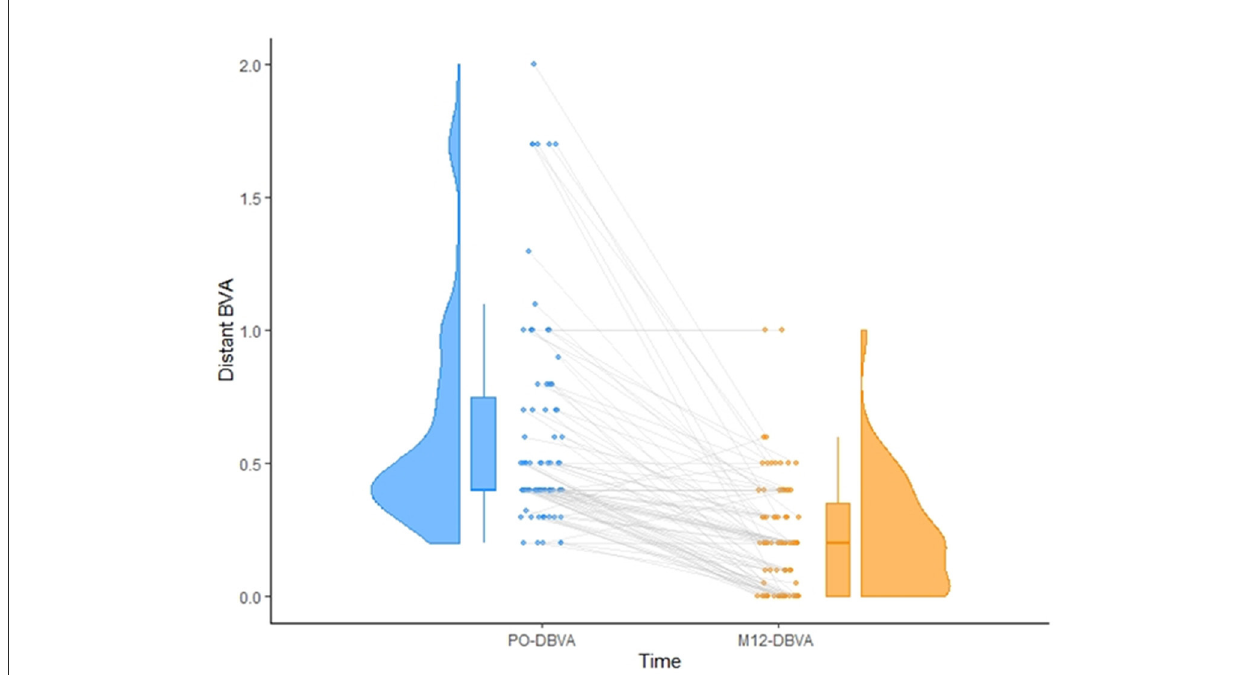
FIGURE1 Matching between preoperative (left) and one-year postoperative (right) distant BCVA (logMAR). Representation of the inter-individual variability in recovery is also given.